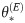
Increasing nonlinearity reduces the noise load in the bistable region, decreasing also the epimutation rate.(A) The noise load (Eq 11) is calculated for the solution genotypes θ*(E) for each environmental state, LOW and HIGH. (B) The maximum noise load comparing θ*(E) in both environmental states for each value of nH and KD (with k*(E) depending on the environment being considered). (C) The probability of an individual with a solution genotype θ*(L) (or θ*(H)) and initial phenotype A(L) (or A(H)) has a good fitness score ω in the alternative environment at the end of the generation, i.e. ω(H)(Aτ=4) ≥ 0.5 (or ω(L)(Aτ=4) ≥ 0.5), which is considered as a LOW → HIGH “epimutation” (or HIGH → LOW “epimutation”). (D) The minimum probability of “epimutation” comparing θ*(E) in both directions, LOW → HIGH and HIGH → LOW, for each value of nH and KD (with k*(E) depending on the environment being considered). Values less or equal to 10−6 are omitted. Same range of values and bistable region lines as in Fig 4.